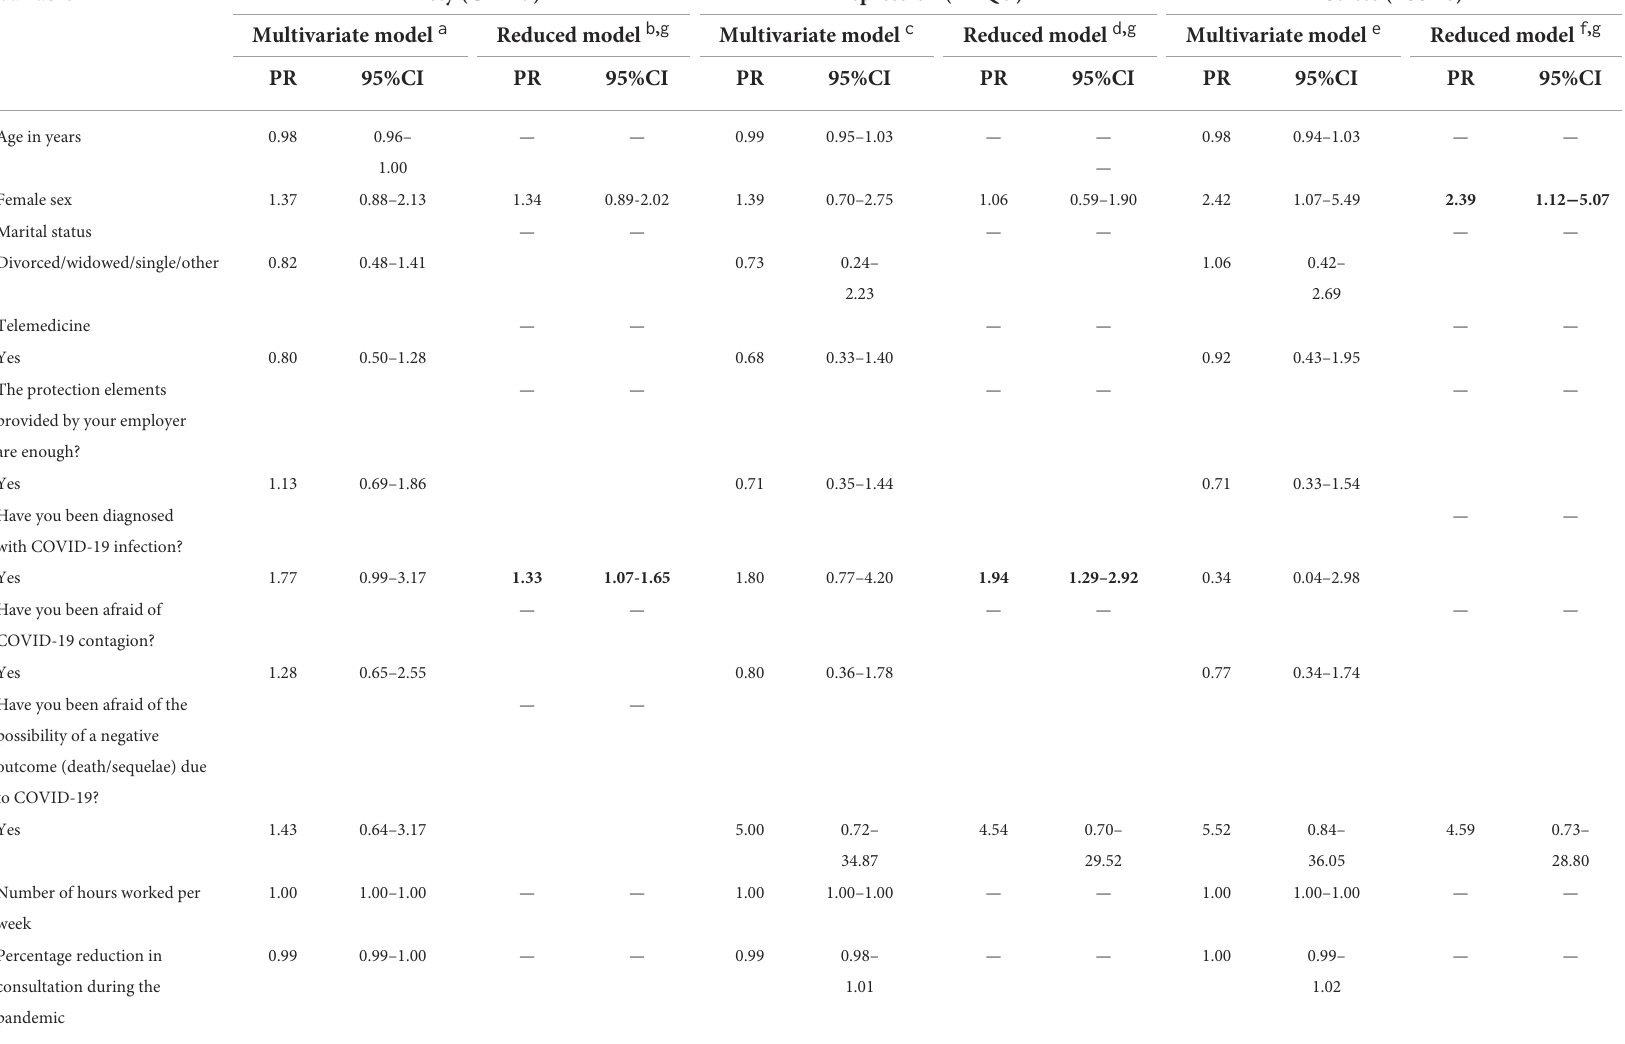
TABLE 5 Factors associated with symptoms of anxiety, depression, and stress. Variable h Anxiety (GAD